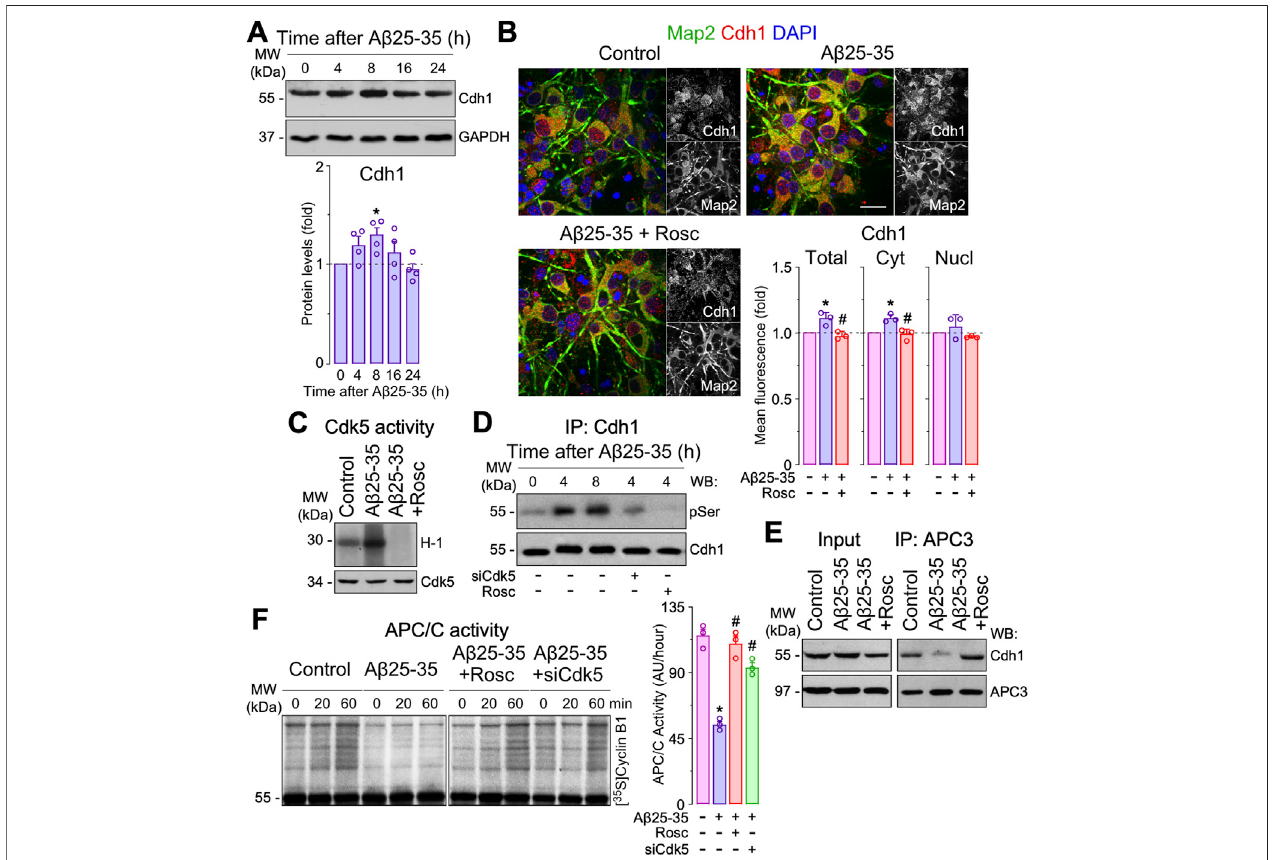
FIGURE1| Amyloid- β (A β )-inducedCdh1phosphorylationdisassemblesCdh1fromAPC3leadingtoAPC/Cinactivation.Primarycorticalneuronswereincubated in culture medium in the absence (control) or the presence of oligomerized A β 25-35 (10 μ M). When indicated, medium was supplemented with roscovitine (10 μ M; Rosc). (A) Cdh1 western blot analysis in neurons at different time points of A β 25-35 incubation (GAPDH, loading control). Cdh1 western blot bands were quanti fi ed by densitometry and data were expressed as the fold change relative to 0 time ( n = 4 neuronal cultures). (B) Cdh1 and Map2 (neuronal marker)